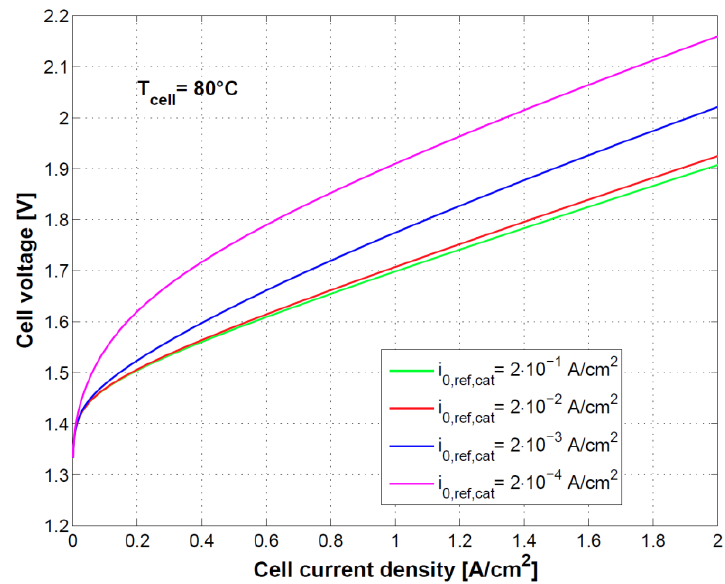
Figure 9. Impact of anode exchange current density on cell polarization curve.